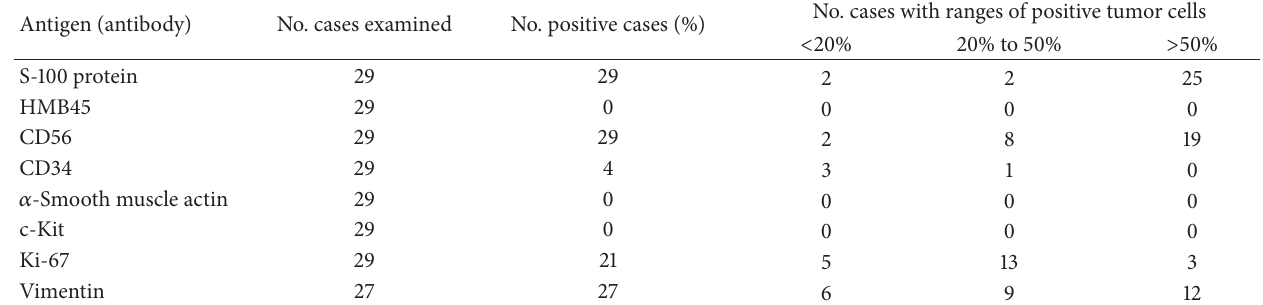
Table 2: Summarized immunohistochemical results of gastric schwannomas.